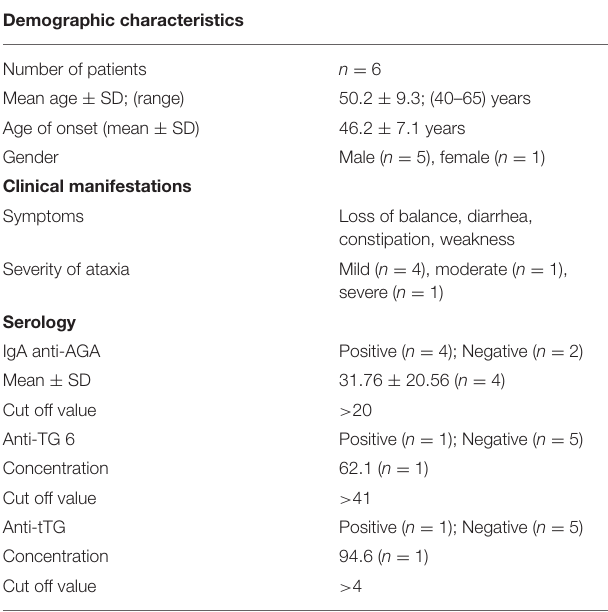
TABLE 1 | Demographic characteristics, clinical manifestations, and serology of patients with Gluten